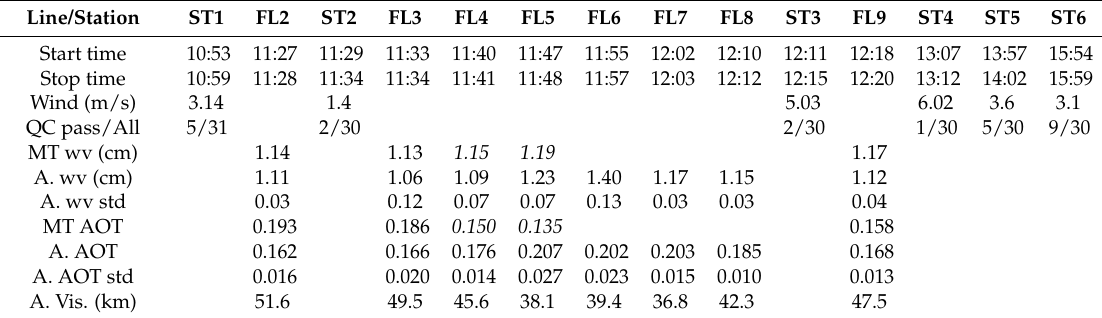
Table 1. Flight lines, in situ reference measurements and atmospheric parameters during the campaign. FL2-9: flight line number, ST1-6: in situ measurement station number. Times are local time (BST). Wind: average wind speed during station measurements. QC pass/All: number of individual spectrum that passed the automatic quality control during station measurements. In situ water vapour and AOT values used for atmospheric correction strategy AC3 are given in italics. wv: columnar water vapour, AOT: aerosol optical thickness, Vis: horizontal visibility, A.: parameter derived by ATCOR (wv and AOT with standard deviations, MT: Microtops sun photometer used for in situ AOT and water vapour